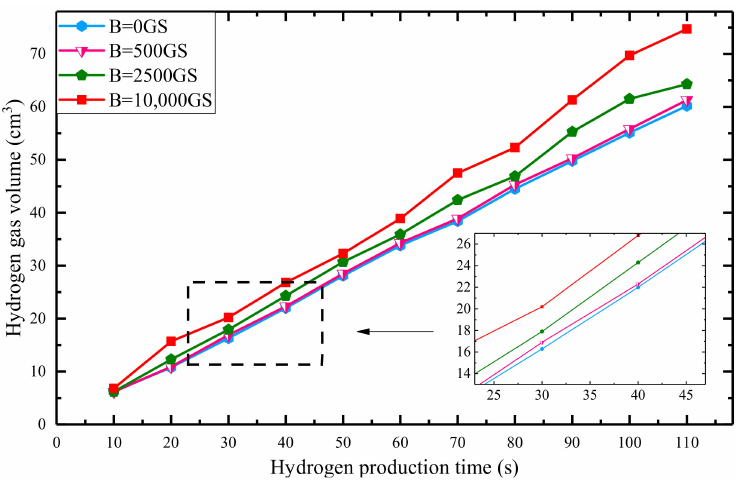
Figure 9. Variation in hydrogen production from distilled water with time after pre-polarization of different magnetic